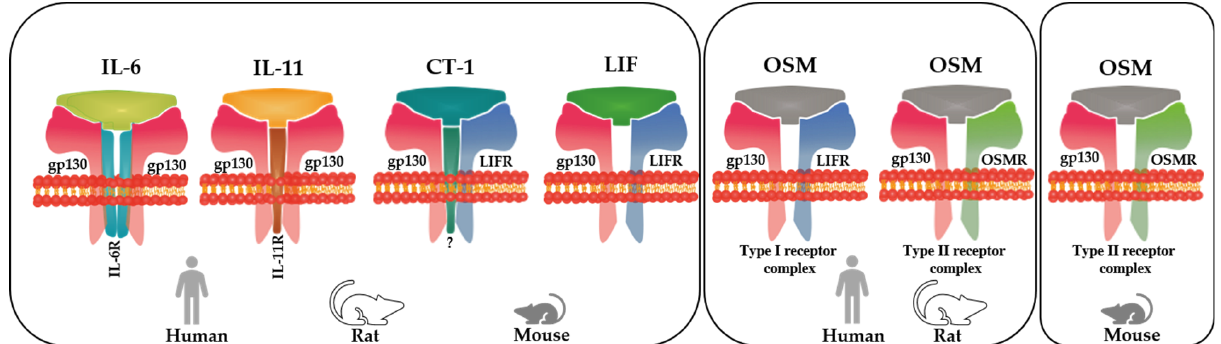
Figure 1. Simplified scheme illustrating the members of the interleukin-6 family of cytokines and their receptor complexes involved in adult cardiomyocyte remodeling and the differential formation of receptor complexes by OSM in the human, rat, and mouse. IL-6, IL-11, CT-1, LIF, and OSM elicit receptor complex activation in cardiomyocytes. Amongst them, OSM showed the strongest morphological effect on cultured cardiomyocytes, whereas the other members exerted a strong and comparable effect, except for IL-6, which was less effective because the weakly expressed IL-6 receptor probably needs trans-signaling events. The common co-receptor gp130 may explain the similar morphological responses of cardiomyocytes exposed to the IL-6 family. IL-6 and IL-11 activate two homodimeric gp130 receptor complexes containing the IL-6 receptor and the IL-11 receptor, respectively. In contrast, CT-1, LIF, and OSM do not require an additional non-signaling receptor to form functional complexes because they signal through a complex consisting of gp130 and the LIFR. OSM is unique in terms of receptor binding in that it can bind to both the type I (LIFR/gp130) receptor complex and type II (OSMR/gp130) receptor complex in humans and rats, whereas it binds only to the type I complex in